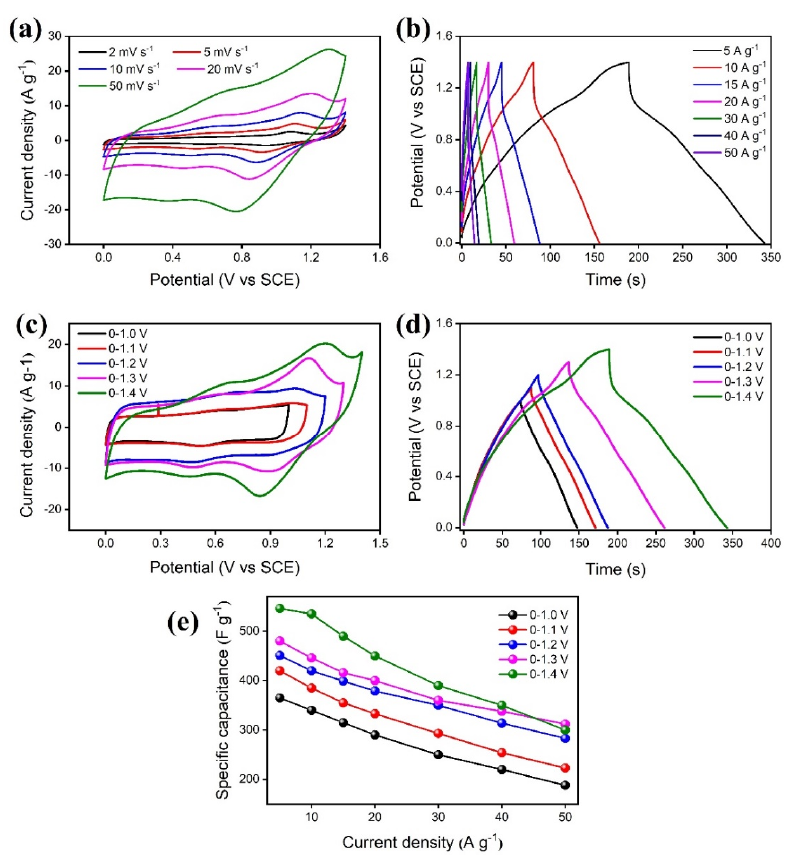
Figure 5. Electrochemical performance of Na 3 -MnO 2 electrode at potential range of 0–1.0, 0–1.1, 0– 1.2, 0–1.3, and 0–1.4 V ( a ) CV curves at 2, 5, 10, 20, and 50 mV s −1 scan rate and 0–1.4 V potential window; ( b ) GCD curves at 5, 10, 15, 20, 30, 40, and 50 A g −1 current densities and 0–1.4 V potential window; ( c ) CV curves comparison at various potential ranges of 0–1.0, 0–1.1, 0–1.2, 0–1.3, and 0– 1.4 V at a scan rate of 10 mV s −1 ; ( d ) GCD curves comparison at different potential windows of 0– 1.0, 0–1.1, 0–1.2, 0–1.3, and 0–1.4 V at 10 A g −1 current density; ( e ) Specific capacitance comparison at various current densities of 5, 10, 15, 20, 30, 40, and 50 A g −1 and 0–1.0, 0–1.1, 0–1.2, 0–1.3, and 0– 1.4 V potential window.